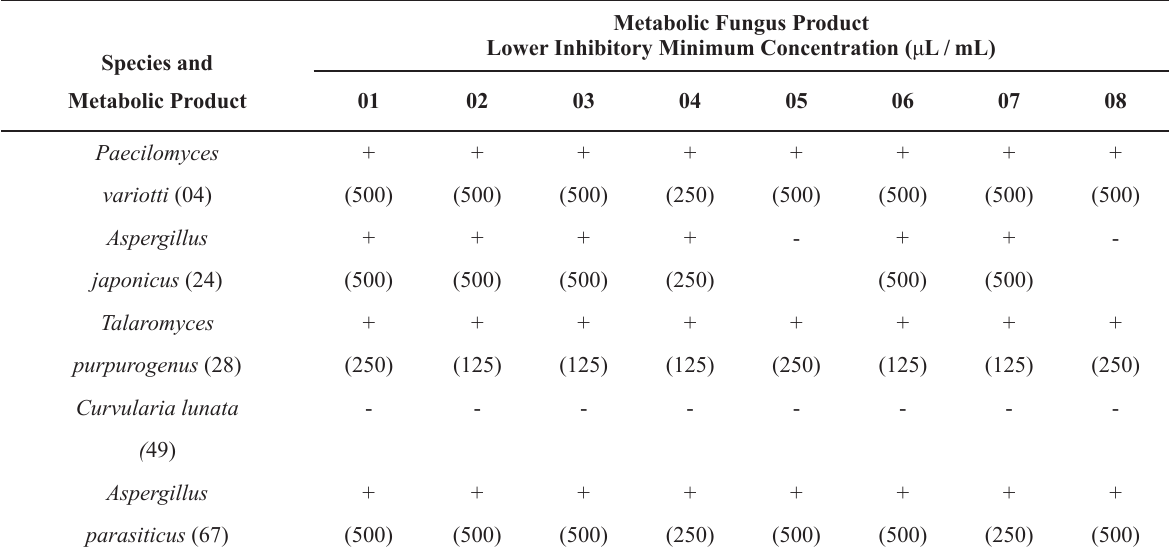
Minimum inhibitory Concentration of the antibacterial activity of the isolated fungi species in the CAV/UFPE air. Metabolic Fungus Product Lower Inhibitory Minimum Concentration ( μ L / Species and